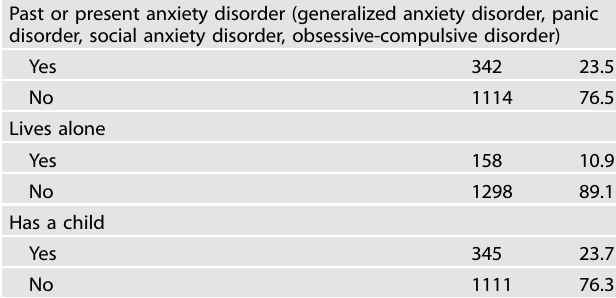
Supplementary Table S3 for statistical details). In line with overall demographics of the web-based research platform used for the study, the current sample was signi fi cantly younger and more likely to be white than the median US population.